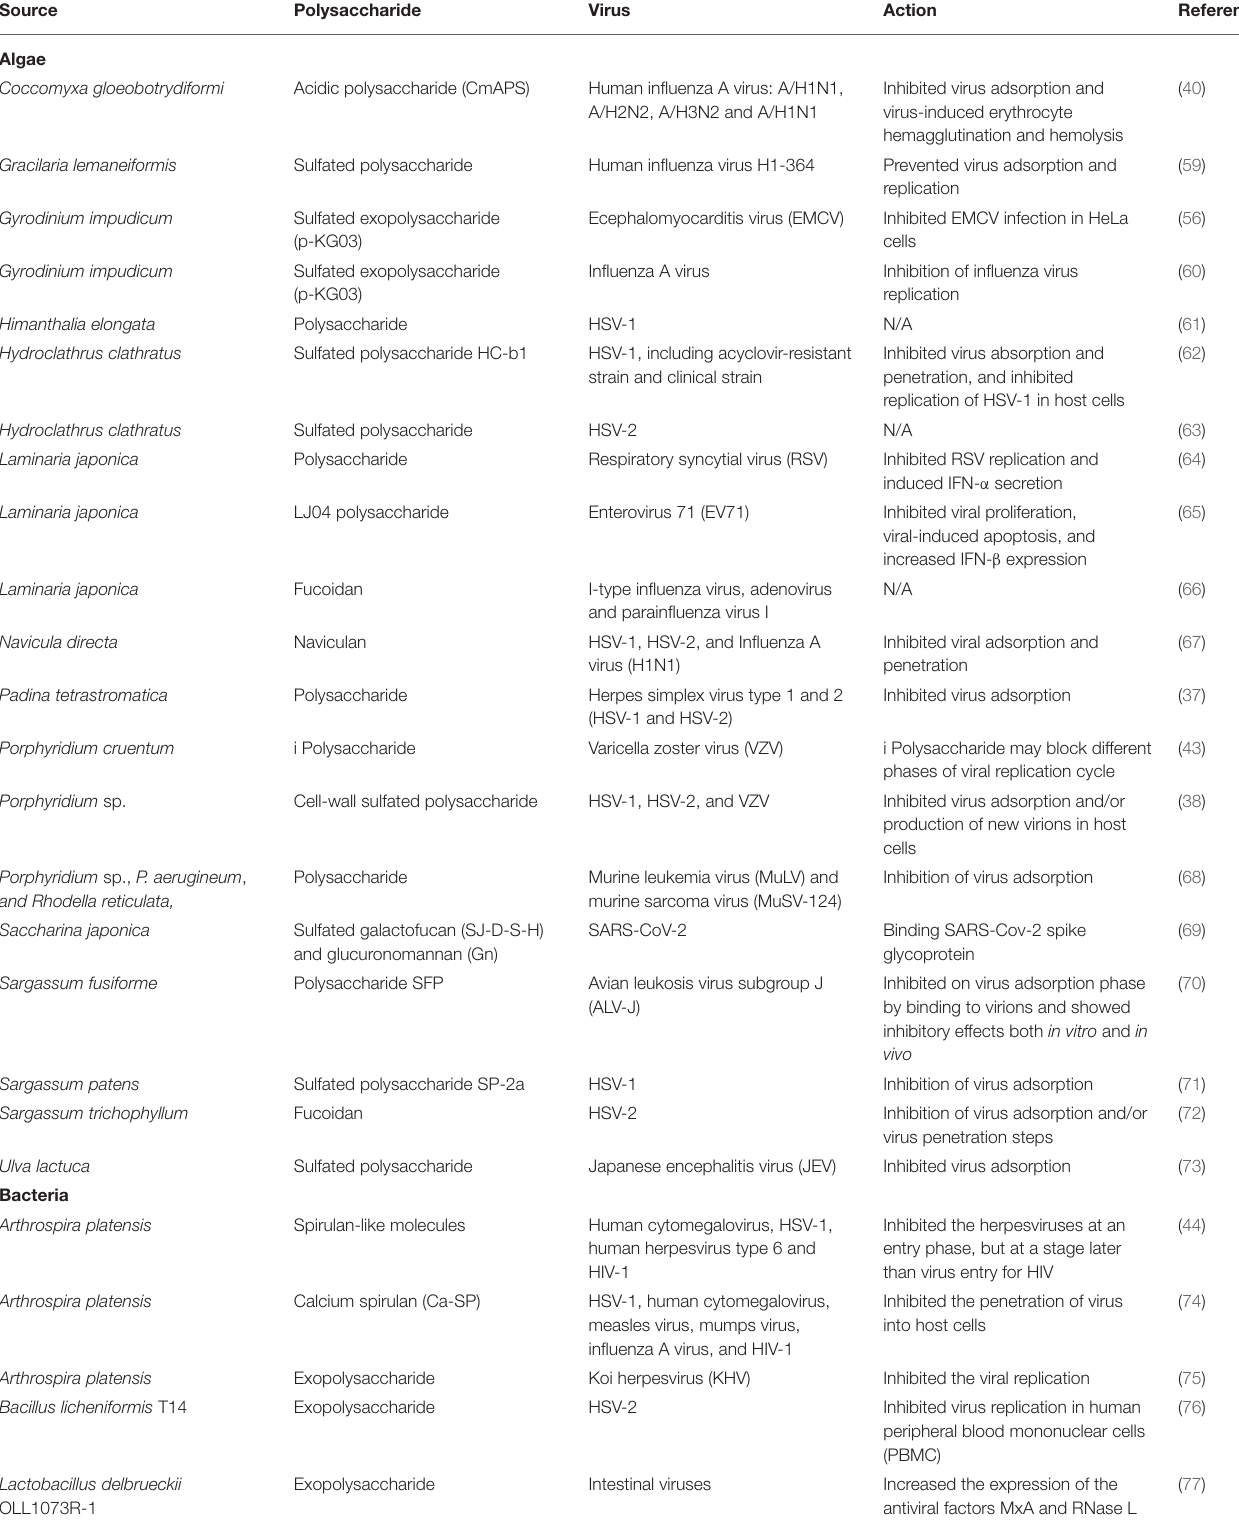
TABLE 1 | The microbial polysaccharides with antiviral